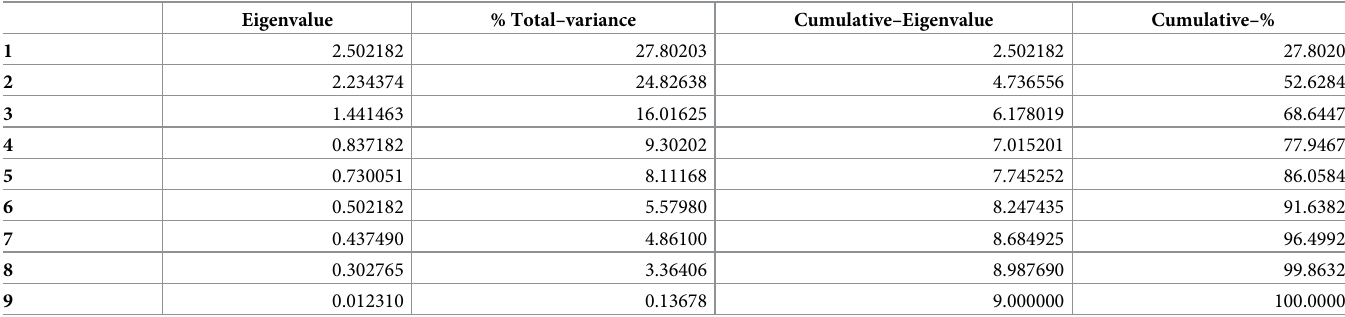
Table 2. Eigenvalues of indicators of economic